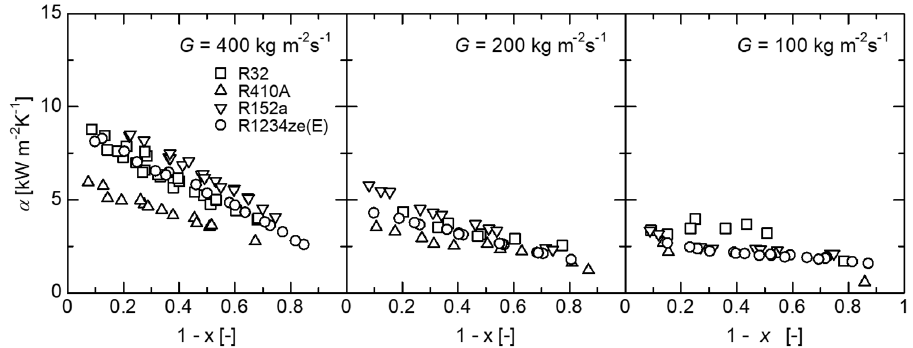
Figure 5. Relationship between condensation heat transfer and wetness for the small-diameter smooth tube.